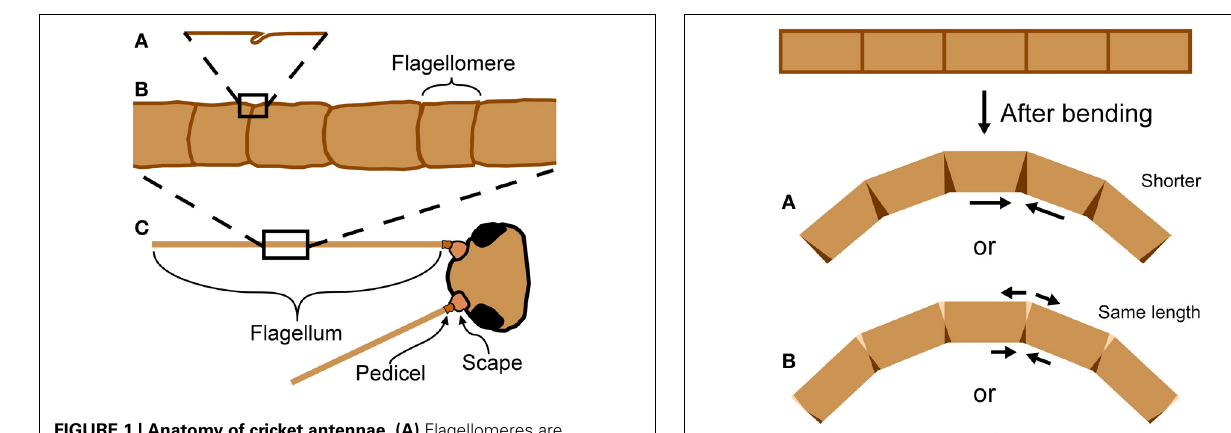
FIGURE 1 | Anatomy of cricket antennae. (A) Flagellomeres are separated by joints of folded cuticle. (B) Flagellum of cricket antenna with large number of flagellomeres. (C) An insect antenna has three true segments: the scape, the pedicel, and the flagellum.